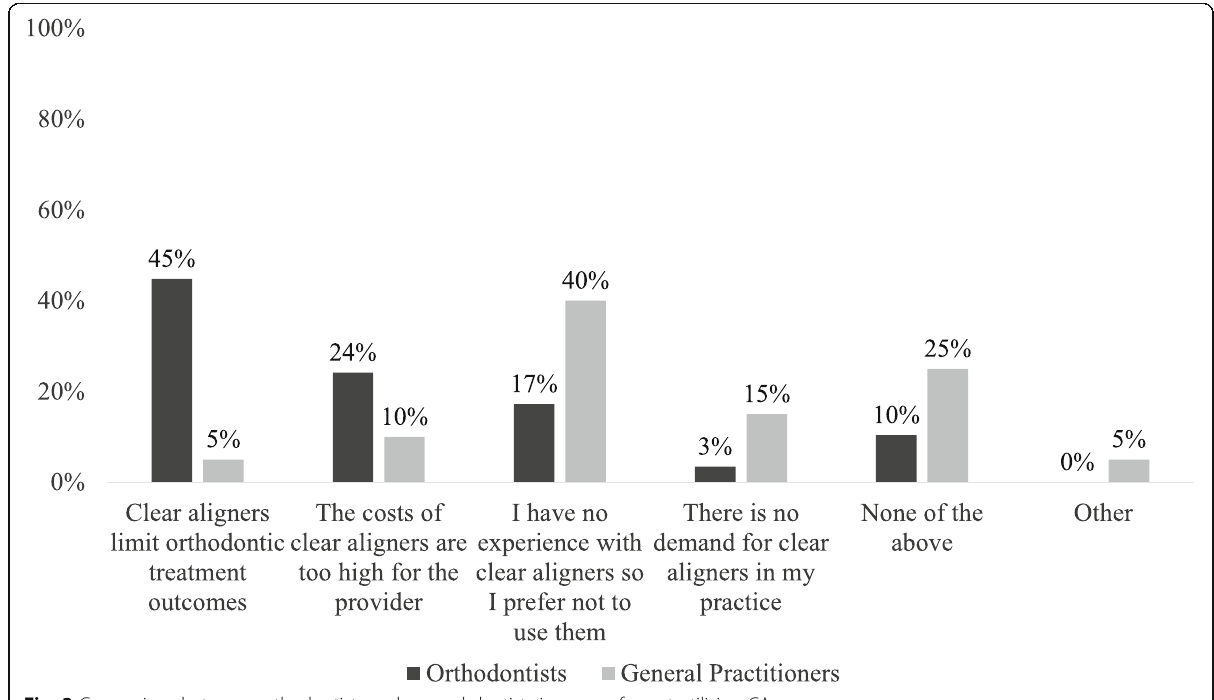
Fig. 3 Comparison between orthodontists and general dentists in reason for not utilizing